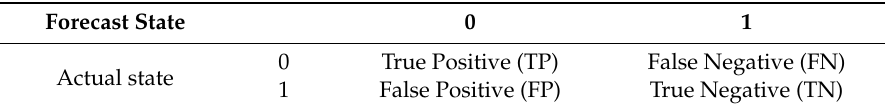
Table 2. Confusion matrix classification